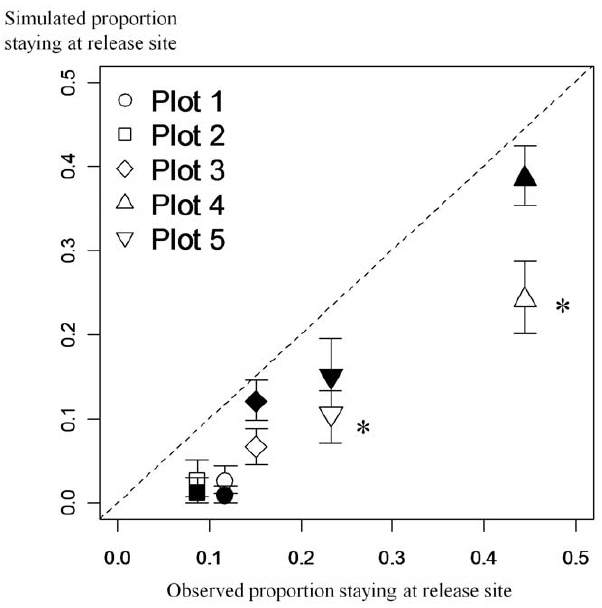
Figure 2. Proportion of individuals staying at their release site in the five banana plots (observed versus simulated by POM). Means for each of the five banana plots and 95% quantile interval (vertical bars) were calculated for the habitat-independent (white) and the habitat-dependent (black) models with the respective maximum likelihood estimates based on 100 runs. The dotted line corresponds to ideal fit between observations and simulations. For each plot, an asterisk indicates a significant difference between the simulated and observed mean ( x 2 test, df=1, P , 0.01).